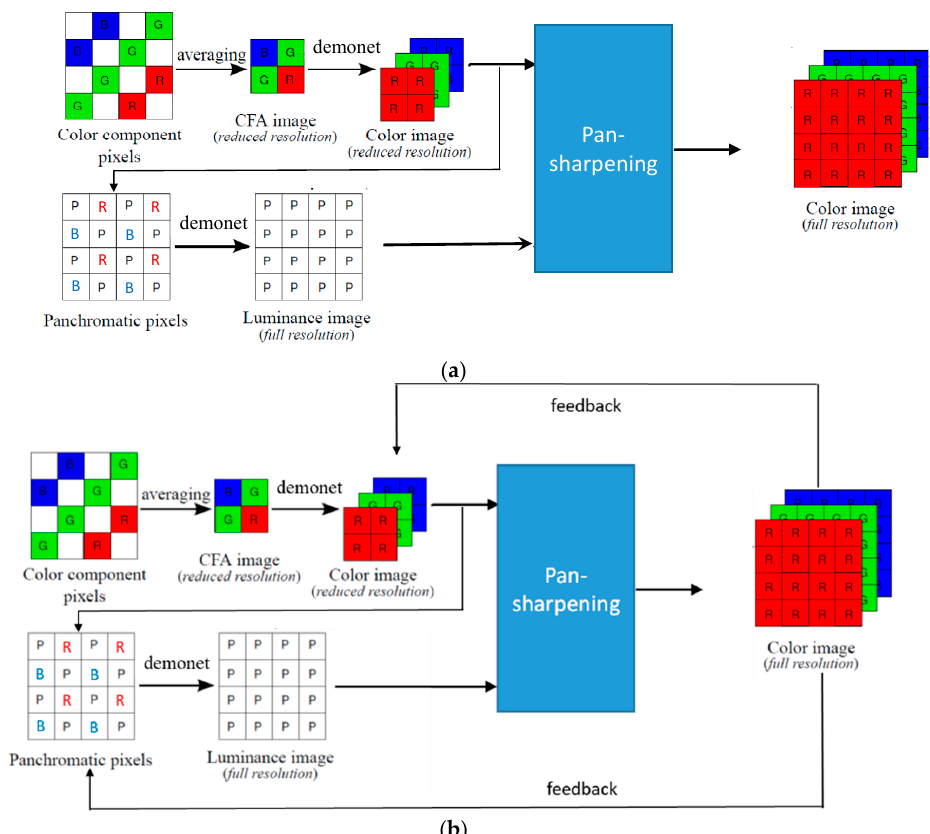
Figure 4. Proposed new deep learning based approach to demosaicing CFA2.0: ( a ) DEMONET based approach without feedback; ( b ) DEMONET based approach with feedback.